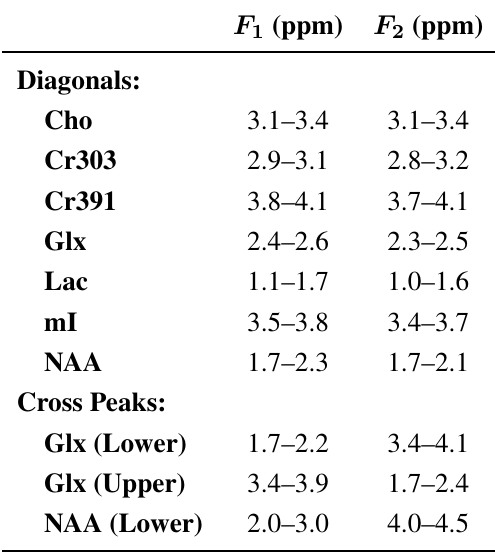
Table 2. F , F ppm ranges used to calculate the metabolite RMSEs shown in Figure 1 2